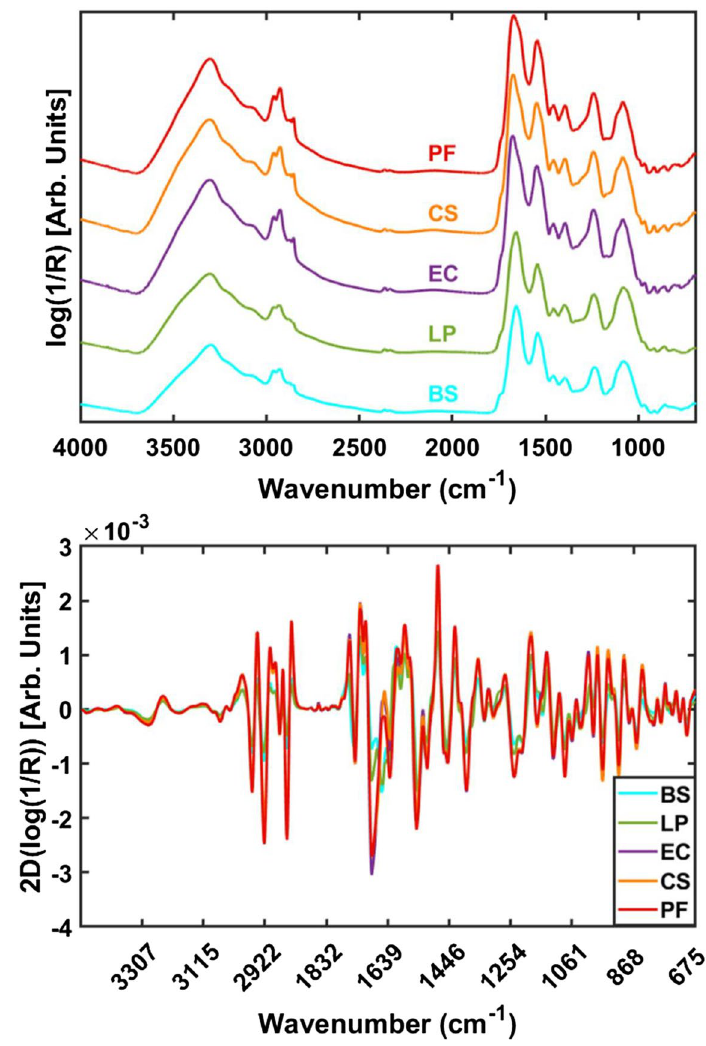
Figure 1. (Top panel): Mean FTIR spectra (after applying asymmetric least squares smoothing to remove baseline) of each bacterial species. The offset is manually added for better visualisation. (Bottom panel): Resultant FTIR spectra after applying the second derivative (window size = 15 points and the polynomial order = 3) on the mean spectrum of each bacterial species. R = Reflectance. Arb.units = Arbitrary units. BS: Bacillus subtilis ; LP: Lactobacillus plantarum ; EC: Escherichia coli , CS: Cronobacter sakazakii ; PF: Pseudomonas